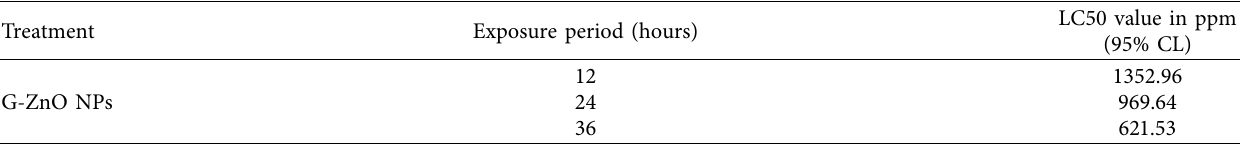
Table 3: Nematicidal activity of G-ZnO NPs against J2s of M. incognita .